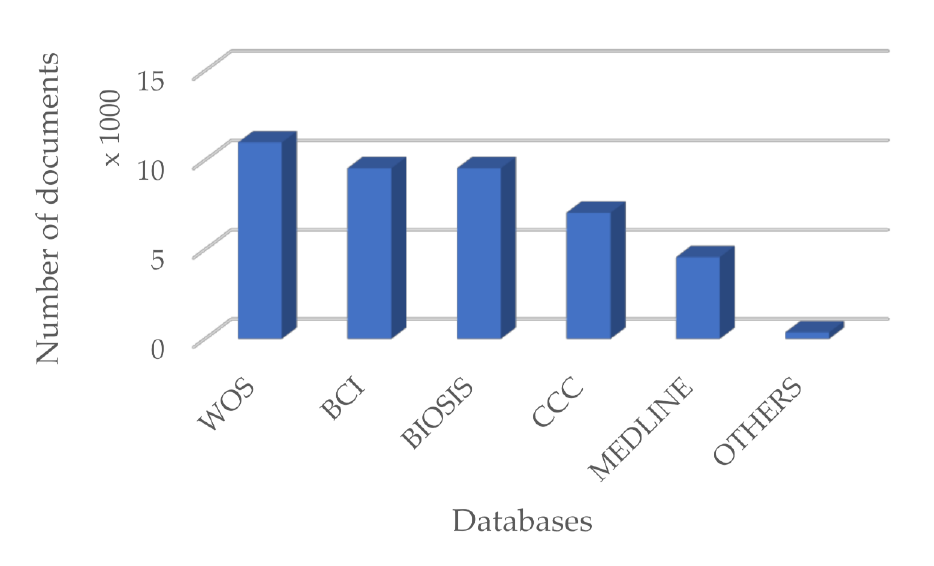
Figure 8. Number of documents on O3 in the plant research field included in the different databases of Web of